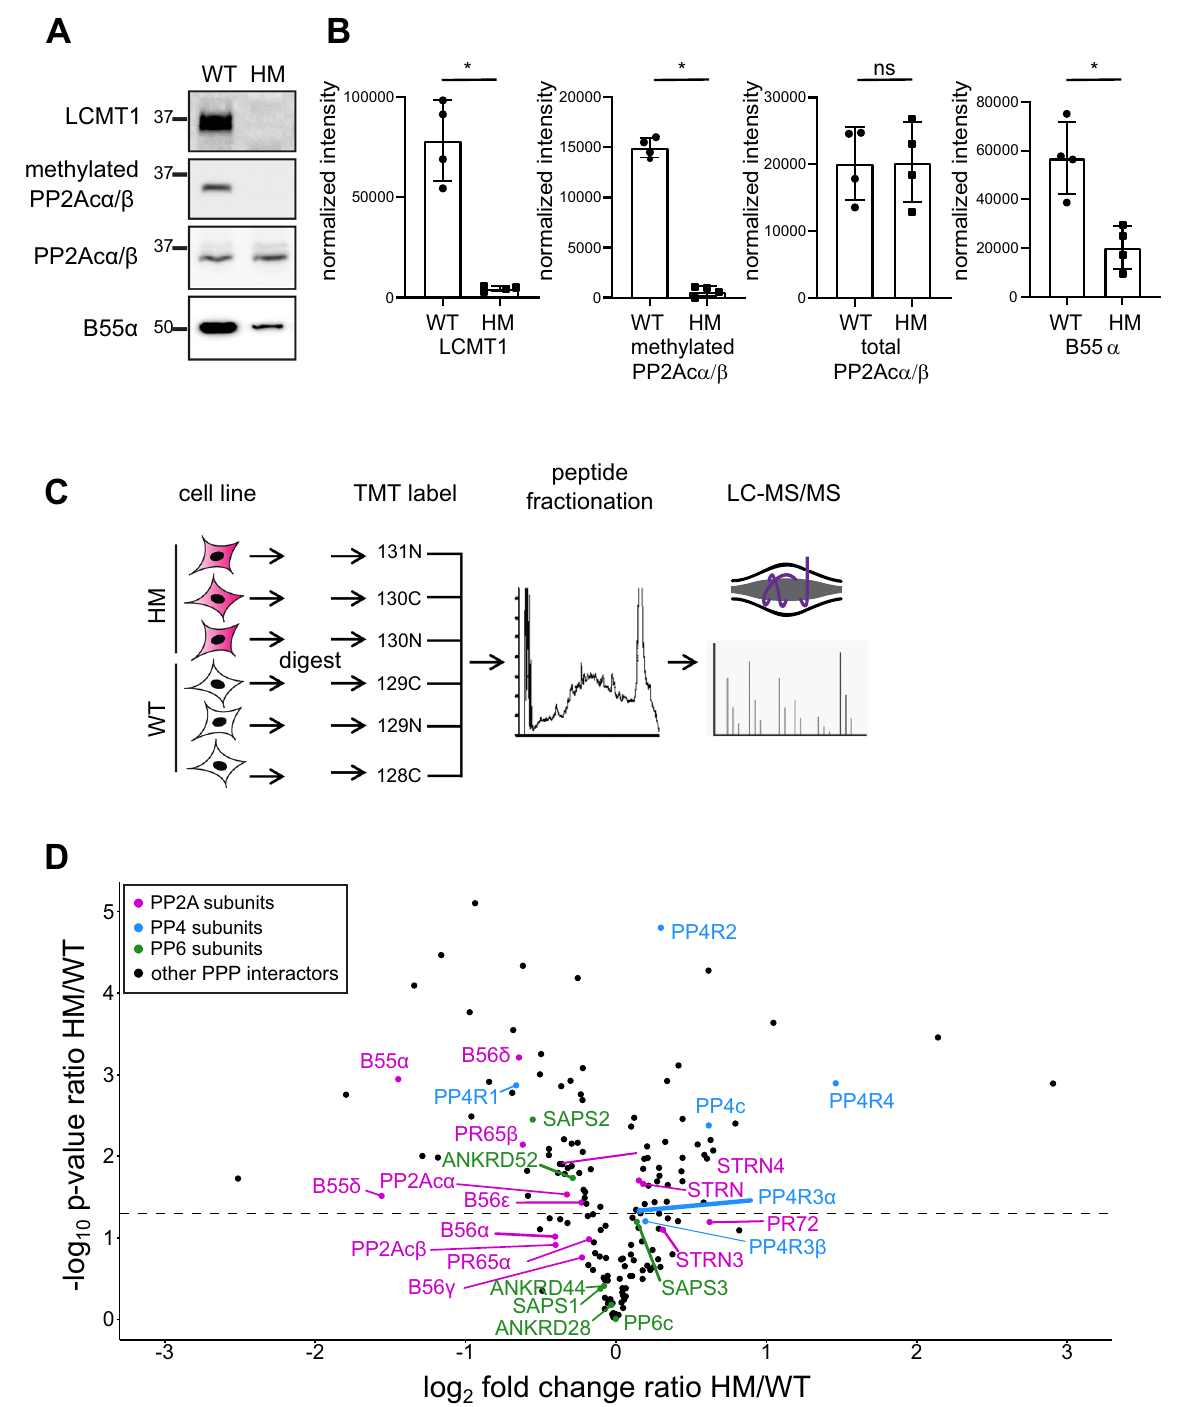
Figure 3. Disruption of LCMT1 in HEK293T cells. HEK293T cells were infected with lentiviruses encoding a gRNA targeting a region within LCMT1 exons 1 or 2. Cells were selected, and single colony screened for LCMT1 and methylated PP2A. ( A ) Wild-type (WT) and hypomorph (HM) lysates probed for LCMT1, methylated PP2Acα/β, total PP2Acα/β, and B55α. ( B ) Western blots were quantified, and individual data points are shown for LCMT1, methylated PP2Acα/β, total PP2Acα/β, and B55α intensities normalized to total protein loading. Error bars represent the standard deviation of four replicates. Mann–Whitney test was performed * p < 0.05, ns – not significant. ( C ) Workflow for proteomic analysis of HEK293T LCMT1 HM cells compared to WTcells. ( D ) Volcano graph of known PPP interactors. The log 2 fold change ratio HM/WT is plotted against the negative log 10 of the p-value of the ratio HM/WT. A p-value cut-off of 0.05 (-log 10 of 1.3) is indicated. PP2A subunits are labeled in purple, PP4 subunits are in blue, PP6 subunits are in green, and other PPP interactors are depicted as black